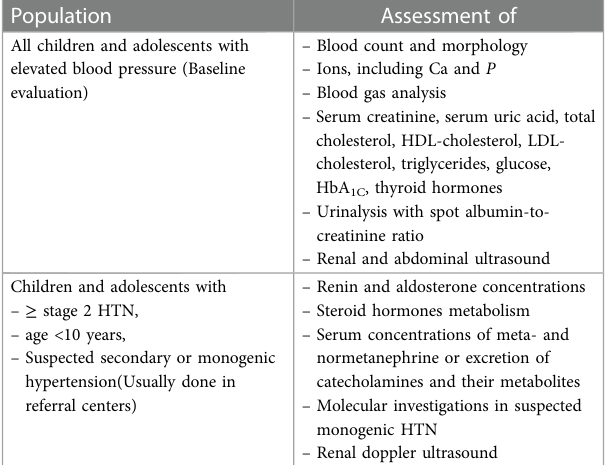
TABLE 2 Physical examination of hypertensive children and adolescents for underlying diseases and additional cardiovascular risk factors. Assessment of